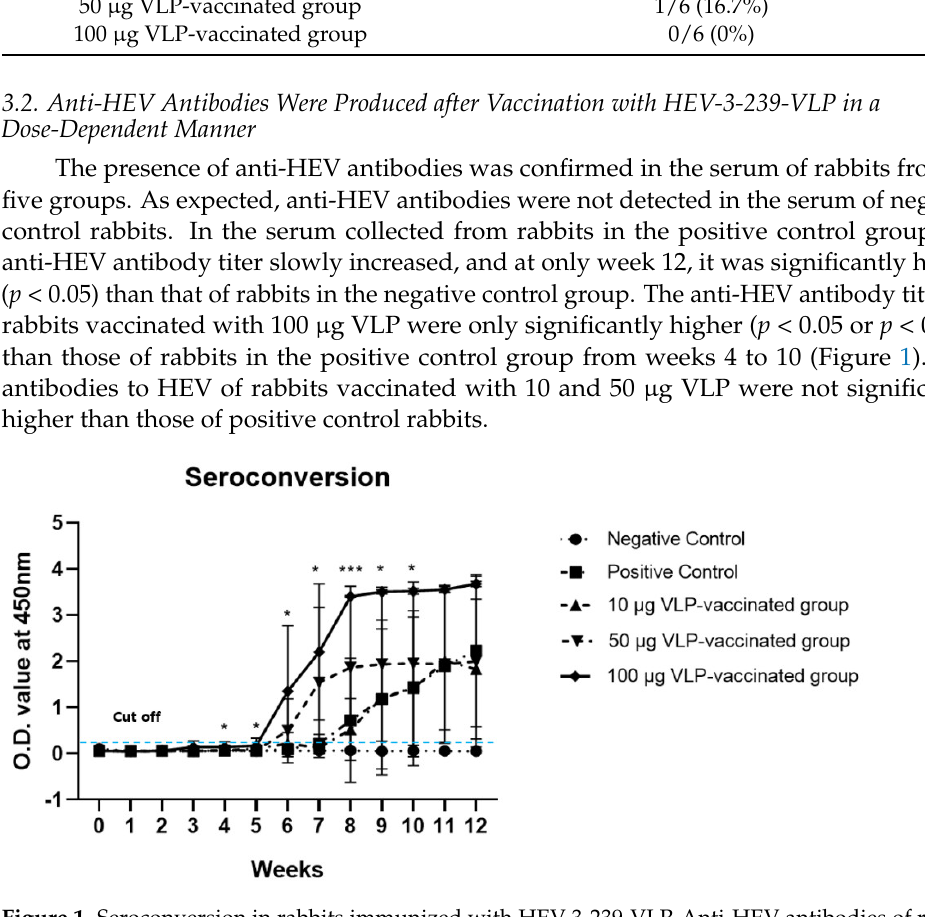
Figure 1. Seroconversion in rabbits immunized with HEV-3-239-VLP. Anti-HEV antibodies of